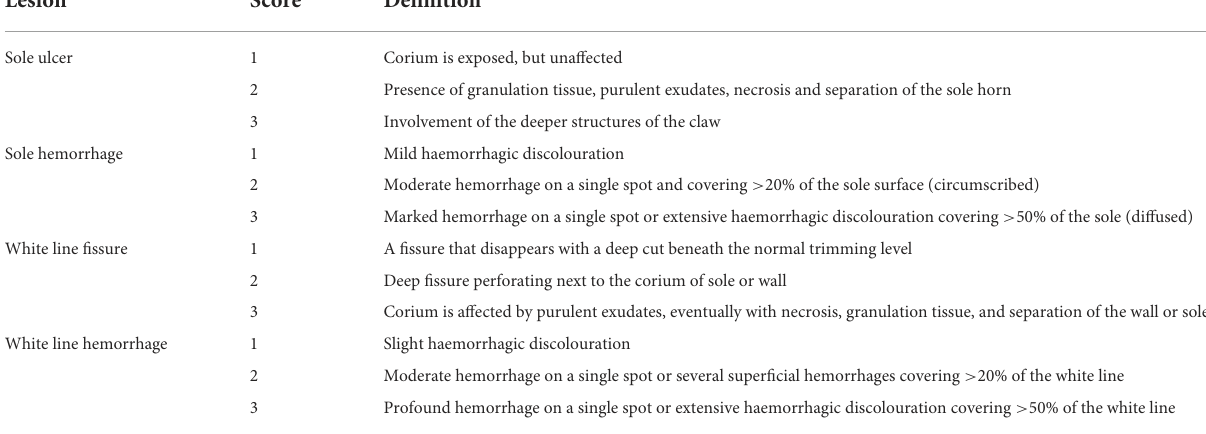
TABLE 1 Definition and categories of severity scores for claw lesions. Lesion